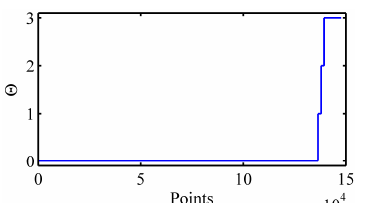
Figure 7. Values of curvature similarity  at non-occluded pixels of a stereo pair